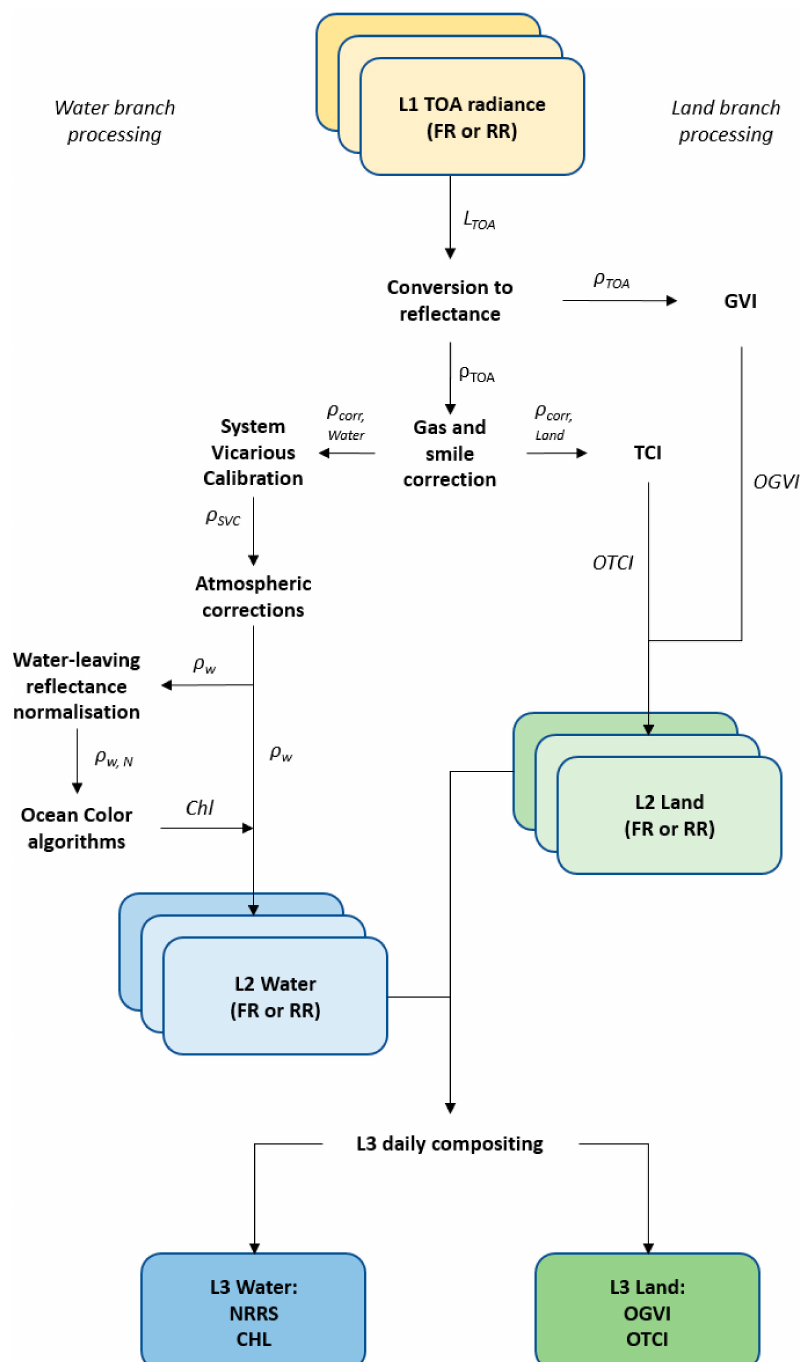
Figure 2. Sketch of the OLCI L2 / L3 processing for land and water branches with emphasis on the main algorithms and products used in this